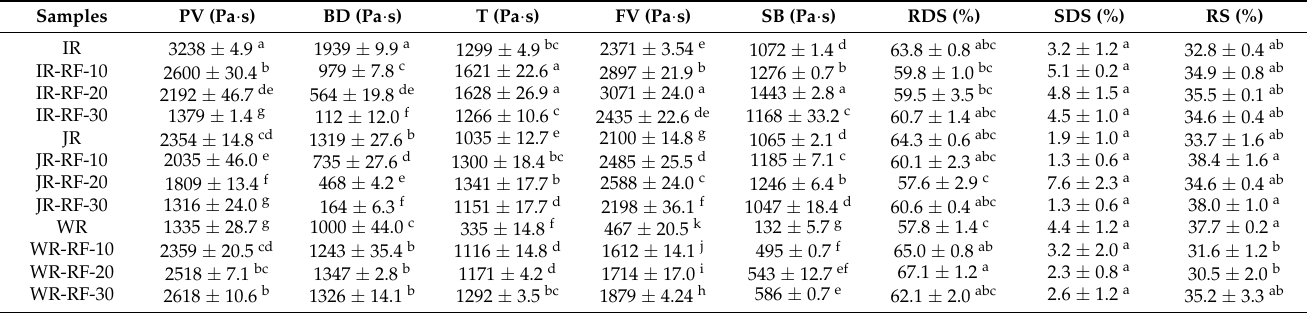
Figure 4. Pasting profile of native and RF-treated rice at different treatment times (10, 20, and 30 min). The black line corresponds to temperature. IR: indica rice; JR: japonica rice; WR: waxy rice. Table 2. The pasting and in vitro digestibility properties of rice grains subjected to RF